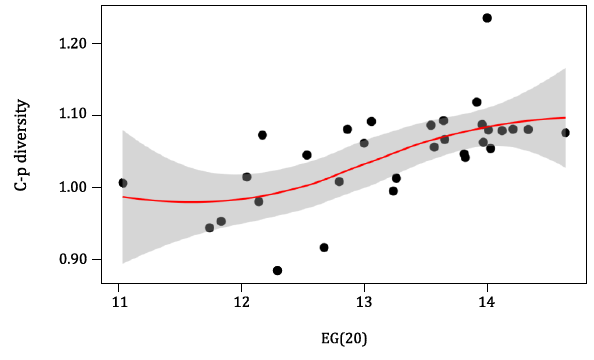
Fig. 4. Significant Spearman rank correlation between taxon diver- sity (EG(20)) and functional diversity (c–p diversity) of nematodes. The red line and associated grey zone represent a LOESS smoother and the 95% confidence interval, respectively. EG(20): expected genus richness for a sample of 20 individuals, c–p diversity: diver- sity of c–p (life history) classes.